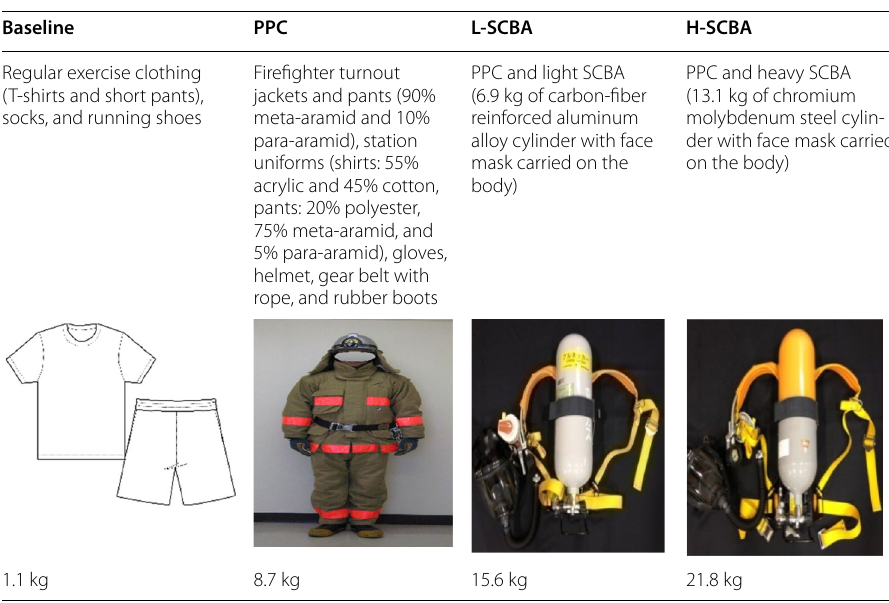
PPC personal protective clothing; SCBA self-contained breathing apparatus